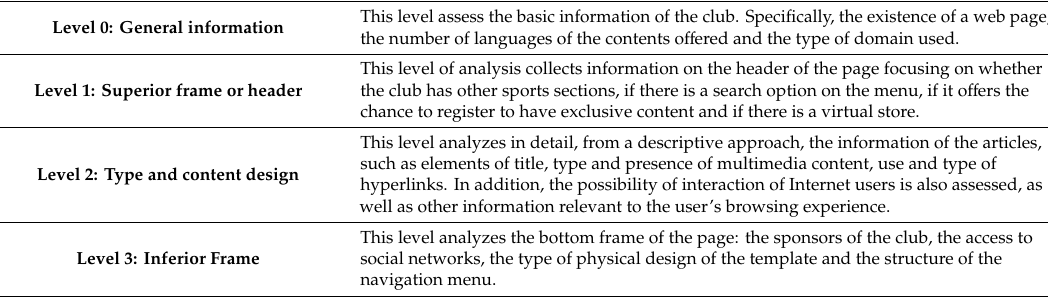
Table 3. Level of the analysis.